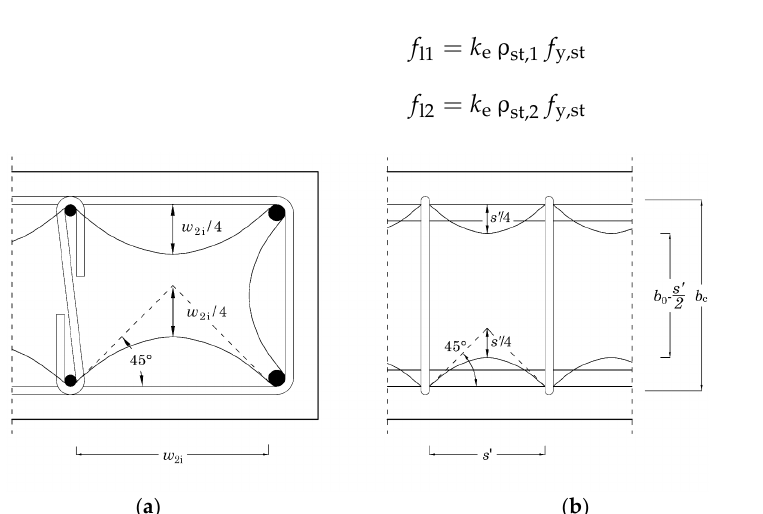
Figure 2. Confinement mechanism in members with stirrups and ties. ( a ) Spreading of the confine- ment stresses in the plane of the transverse reinforcement and ( b ) along the longitudinal axis of the member between two subsequent